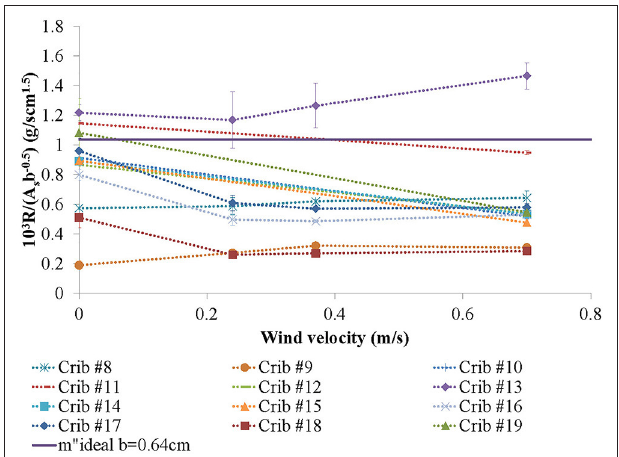
FIGURE 9 | Burning rate under 0.7 m/s normalized by quiescent case as a function of the aspect ratio of the crib